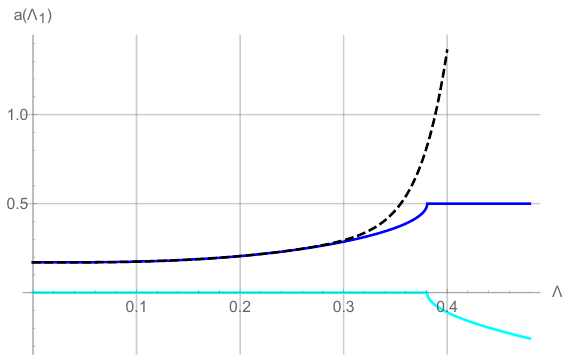
Figure 5. The black dashed line is the a cycle derived with the recursion relation until five instanton for p = 0 . 17 , m = 0 . 7 , the blue line is the real part of the A-cycle and the cyan is its imaginary part derived with